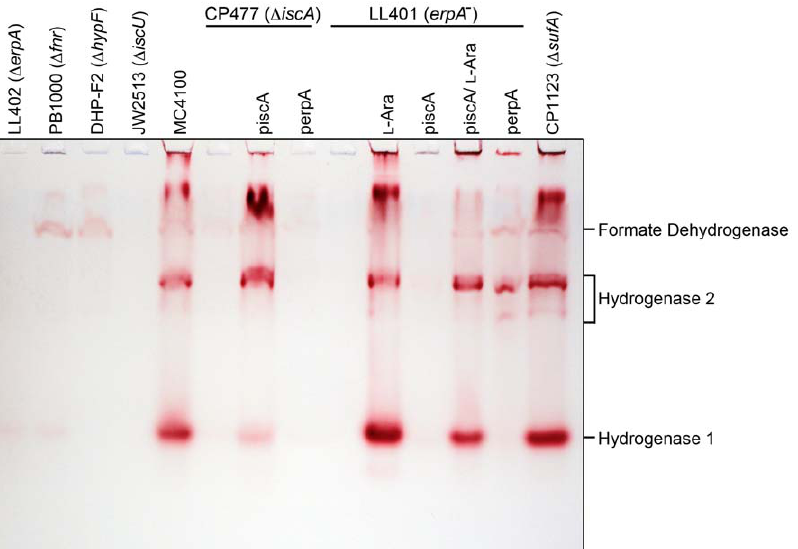
Figure 2. Hydrogenases 1 and 2 are inactive in iscA and erpA mutants. Aliquots of crude extracts (25 m g protein) derived from the bacterial stains shown were separated by non-denaturing PAGE (7.5% w/v polacrylamide) and subsequently stained for hydrogenase enzyme activity. Hydrogenase 1 migrates as a single active enzyme species while hydrogenase 2 shows multiple active forms, which are designated on the right of the panel. The weak hydrogen: benzyl viologen oxidoreductase activity that is independent of the [NiFe]-hydrogenases, and which is associated with formate dehydrogenase [25], is also designated.